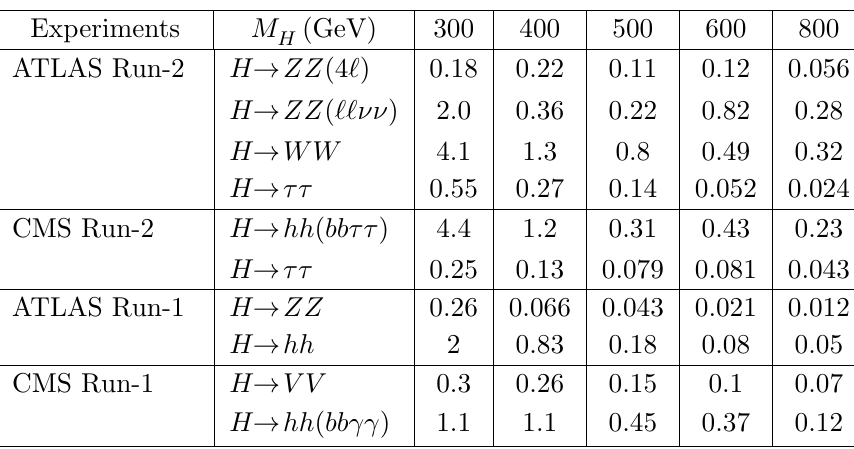
Table 2 . Current upper limits (95% C.L.) from the LHC Run-1 and Run-2 direct searches on the production cross sections (in pb) of the heavier Higgs boson H 0 in various decay channels, where the decay branching fractions of the (cid:12)nal states V V or hh are not included.